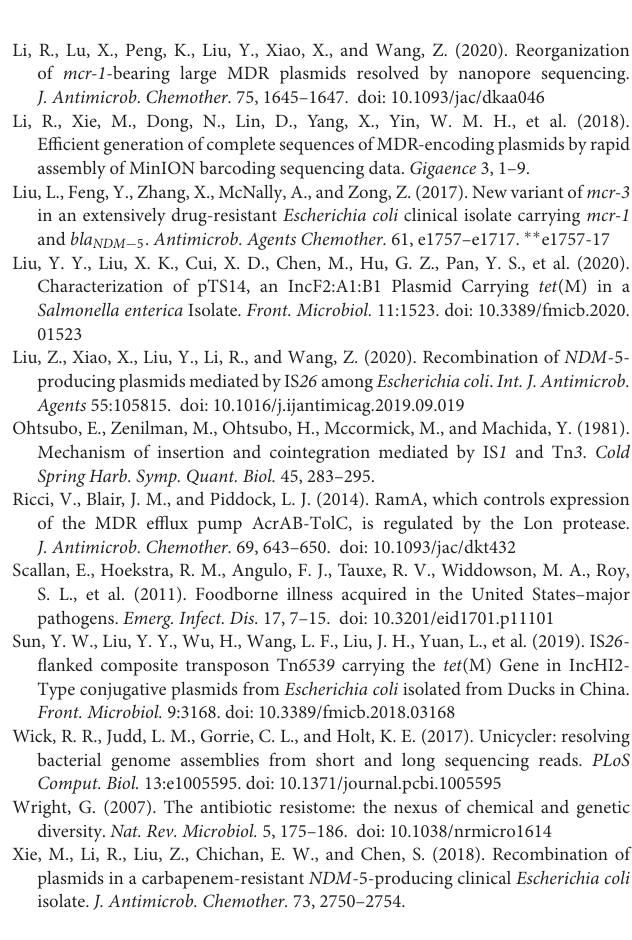
Supplementary Figure 1 | (a) S1-PFGE of S. enterica strain S13 and its three transconjugants S13D, S13F, S13S. (b) . Southern hybridization of S. enterica strain S13 and the tet (M)-bearing transconjugant S13D with the tet (M) gene as the probe. Marker, Salmonella Braenderup H9812. Supplementary Figure 2 | Structural comparisons of pS13-4 and the similar plasmids. The outer ring represents the CDSs of the reference sequence pS13-4. The similar plasmids including the E. coli plasmids pD72-mcr1 (CP035313), pZR78 (MF455226), and pGD27-62 (MN232192); S. enterica plasmid pATCC10729_02 (CP019188); and Klebsiella pneumoniae plasmids pMCR_SCKP-LL83 (MF510496) and p160070 -MCR (MG288678). Supplementary Table 1 | Primers used for PCR and DNA sequencing in this study. Supplementary Table 2 | The MICs of S13 and its transconjugants in this